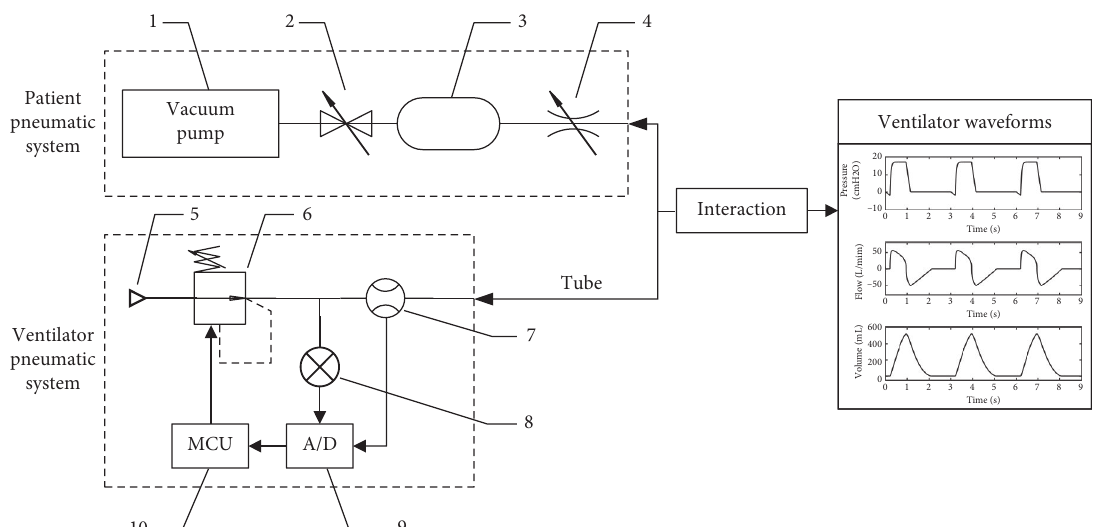
Figure 1: Principle diagram of the pneumatic model of the mechanical ventilation system. 1: vaccum pump, 2: brake valve, 3: variable- volume container, 4: throttle valve, 5: air supply resource, 6: control valve, 7: flow sensor, 8: pressure sensor, 9: data acquisition module, 10: microprogrammed control